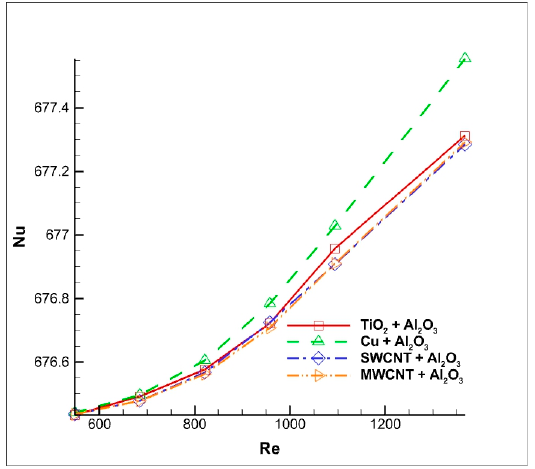
Figure 10. Variation of Nusselt number with respect to Reynolds number.